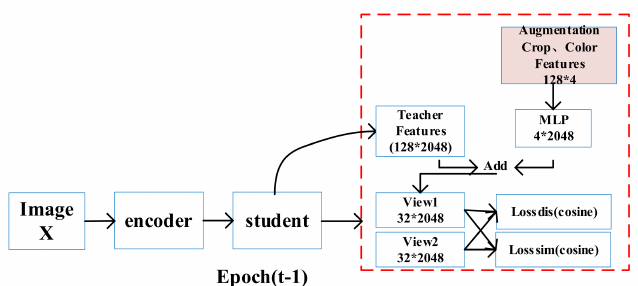
Figure 1. Self − supervised self-distillation module: Simdis2x. Part II: The second branch retained the initial fine-grained feature information to avoid the loss of global spatial information. The later experiments also proved that this structure does reduce the location errors and achieve the location feature extraction process (Figure 2).